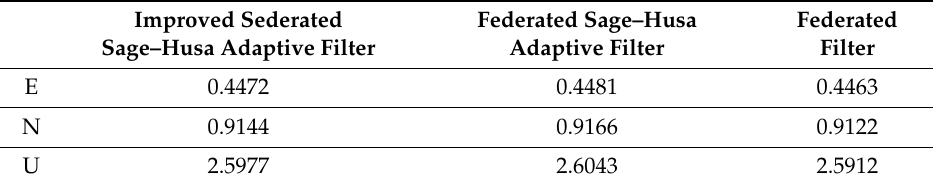
Table 2. Velocity error